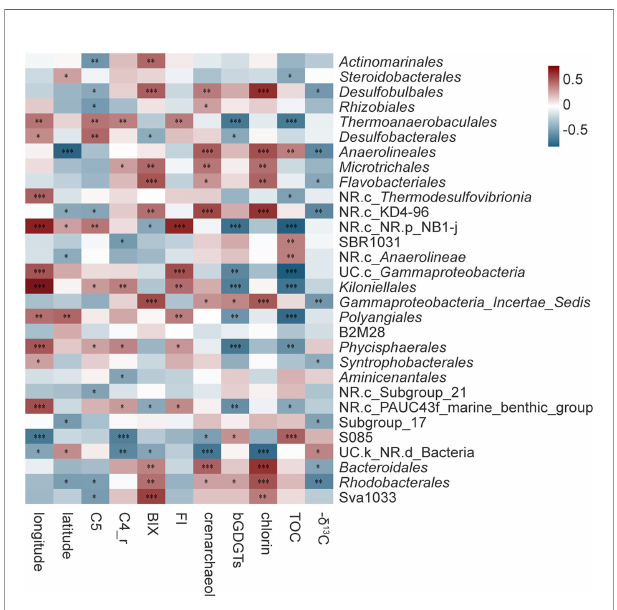
FIGURE 5 | Correlation matrix among environmental factors and four richness estimators. Only Spearman ’ s rank correlations with p < 0.5 are shown. The area and color of the sector indicate the correlation coef fi cients, with red for positive correlations and blue for negative ones. sobs, the observed richness; pd, phylogenetic diversity; HIX, humidi fi cation index; iGDGTs, isoprenoid glycerol dialkyl glycerol tetraethers; BIT, branched and isoprenoid index; Protein, Humic & FDOM, fl uorescence intensity in the Raman Unit of protein-like components, humic-like components & FDOM; Humic_r & Protein_r, proportions of total intensity (i.e., relative intensity) of protein-like components, humic-like components. a 254 & a 340 , absorption coef fi cient at the wavelength of 254 nm & 340nm; S 275_295 , spectral slope from 275nm to 295nm; SR, spectral slope